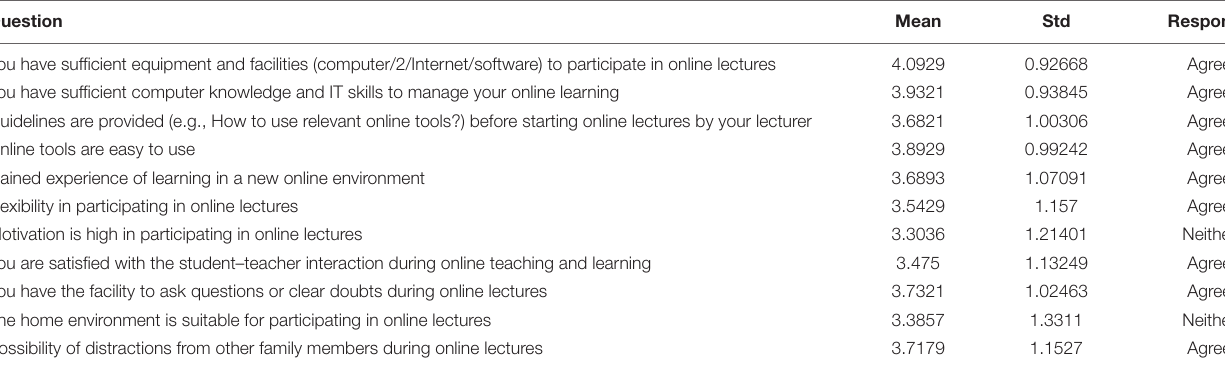
TABLE 4 | The perception of online teaching & learning during the covid-19